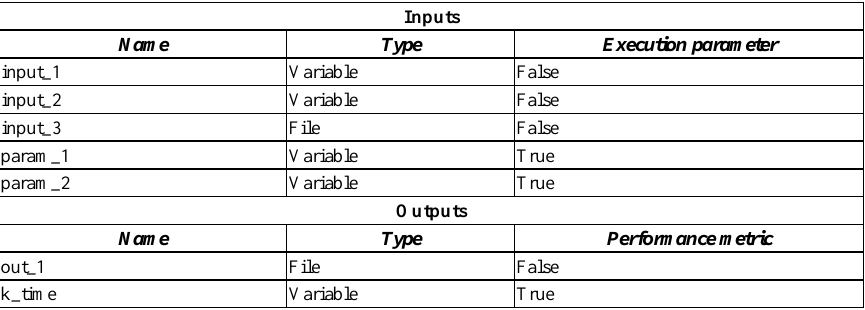
Table 1. Input / output configuration